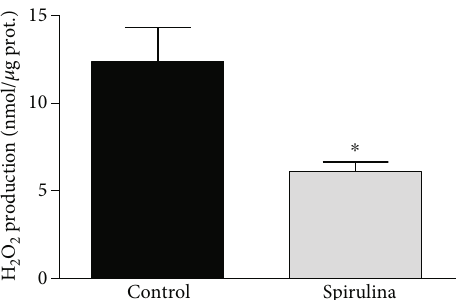
Figure 6: E ff ect of the aqueous Spirulina extract incubation on the production of hydrogen peroxide in aortic segments from SHR. Results ( means ± SEM ) are expressed as nanomoles of H microgram of protein. Number of animals: 5. ∗ p < 0 : 01 compared with the control condition (in absence of Spirulina